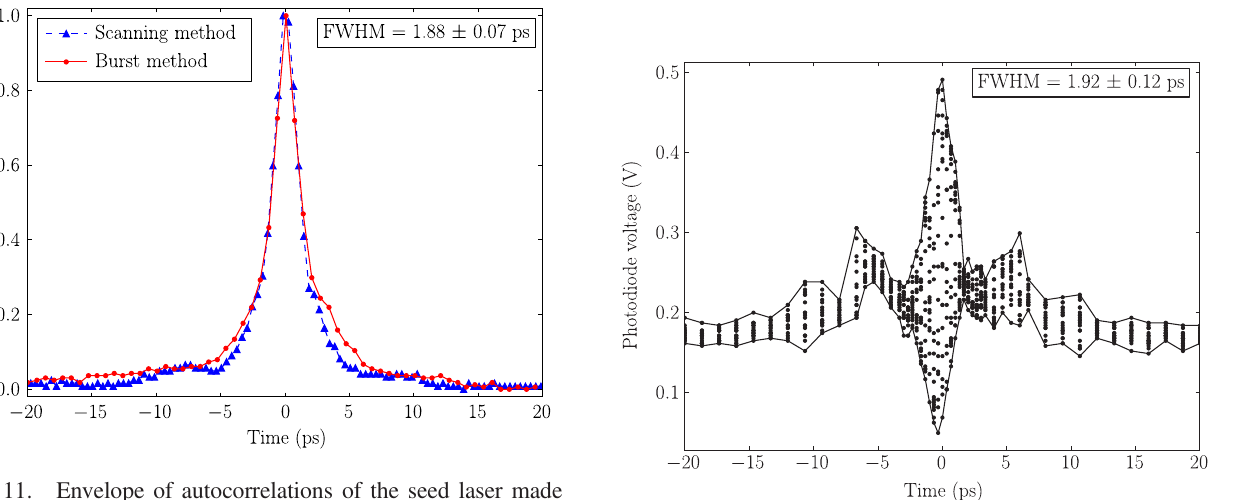
FIG. 11. Envelope of autocorrelations of the seed laser made using both the conventional scanning method and the burst operation method showing good agreement with identical FWHM.